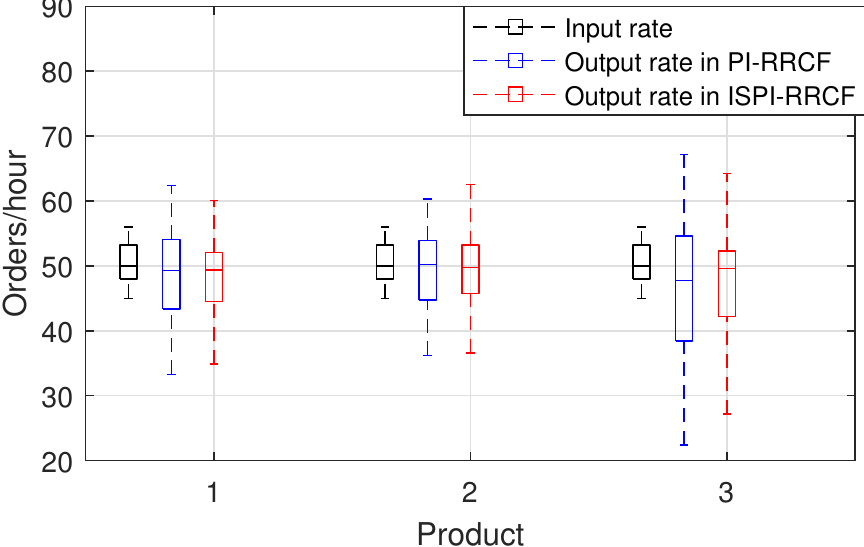
Figure 12. Input and output rate distributions of the